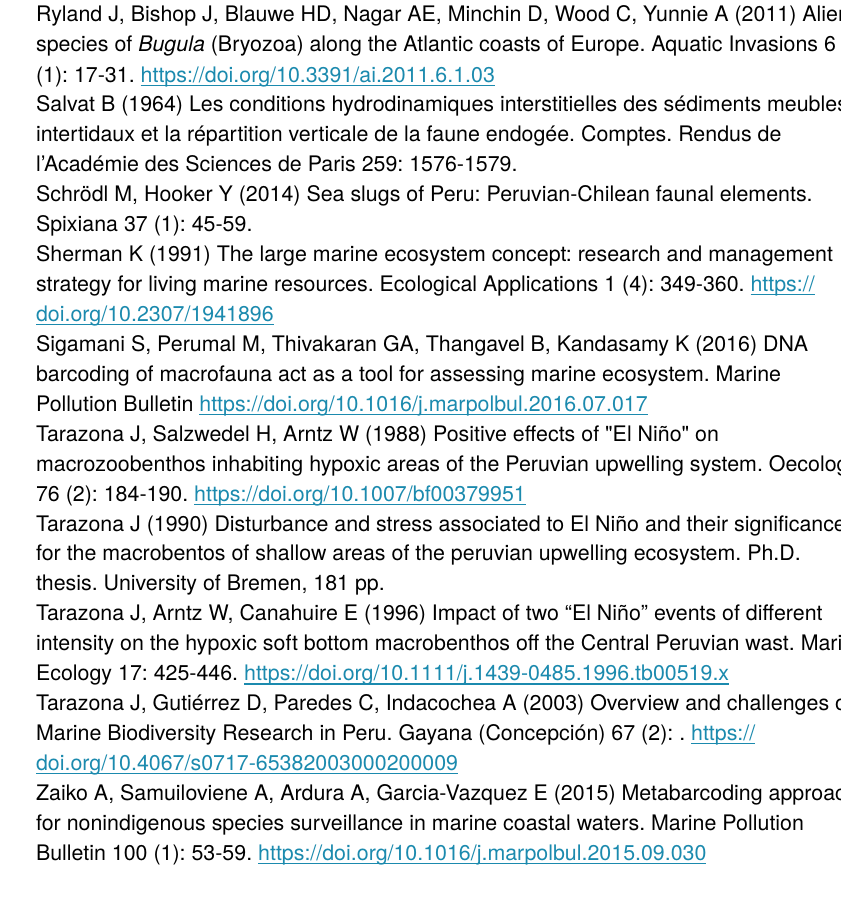
Suppl. material 1: Table 1. Sampling sites at central coast of Peru and in fl uence area of PERU LNG marine terminal, including depth(s), type of substrate and geographic decimal